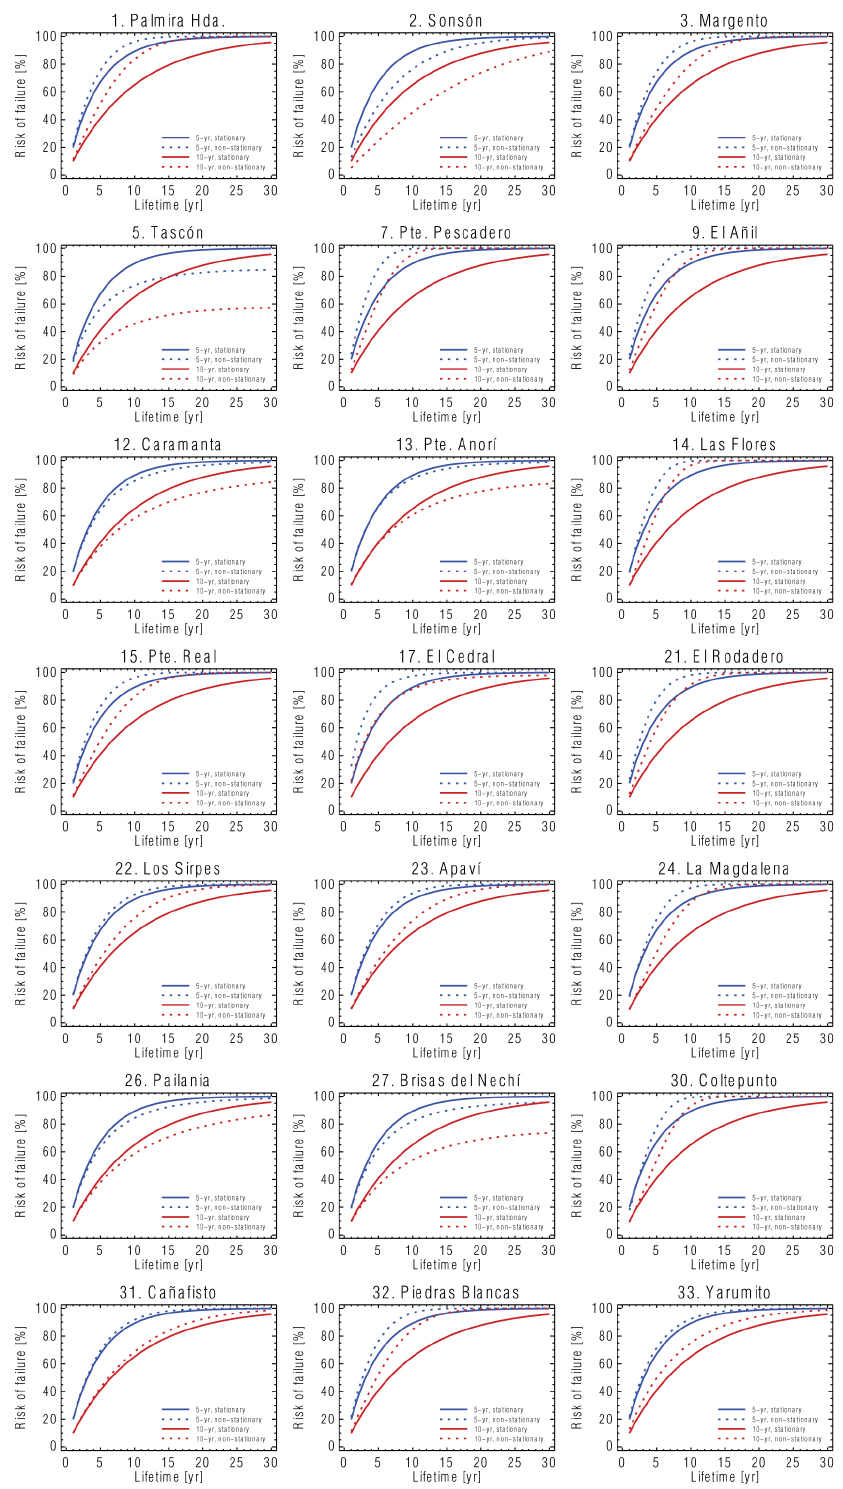
Figure 2. Risk of failure under stationary and non-stationary scenarios for 5-yr and 10-yr return period design for all the non-stationary series of the data